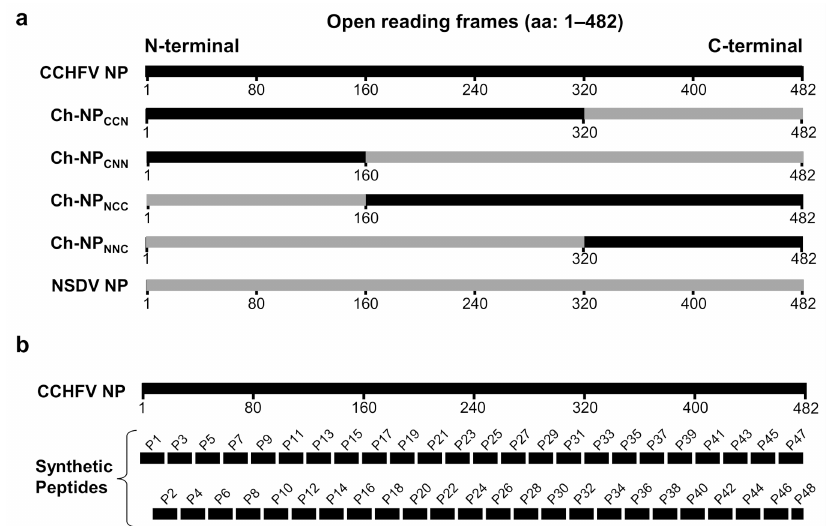
Figure 1. Schematic diagrams of CCHFV and NSDV NPs, their chimeric proteins, and CCHFV NP-based synthetic peptides ( a ) An illustration representing the entire CCHFV (black) and NSDV (gray) NPs and constructed chimeric NPs (Ch-NPs CCN, CNN, NCC, and NNC) is shown. Amino acid positions are indicated below each bar. ( b ) Design and numbers (P1–P48) of 20 amino acid peptides overlapping by 10 amino acids with adjacent peptides, except P48 (12 amino acids) spanning the entire CCHFV